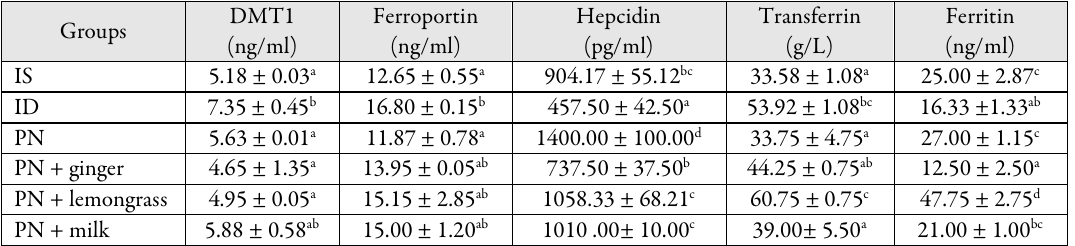
Values are means of three determinations ± SEM. Values with different superscripts down the column are significantly (p < 0.05) different. ISISISIS: Iron Sufficient Rats; IDIDIDID: Iron Deficient Rats; PNPNPNPN: P.